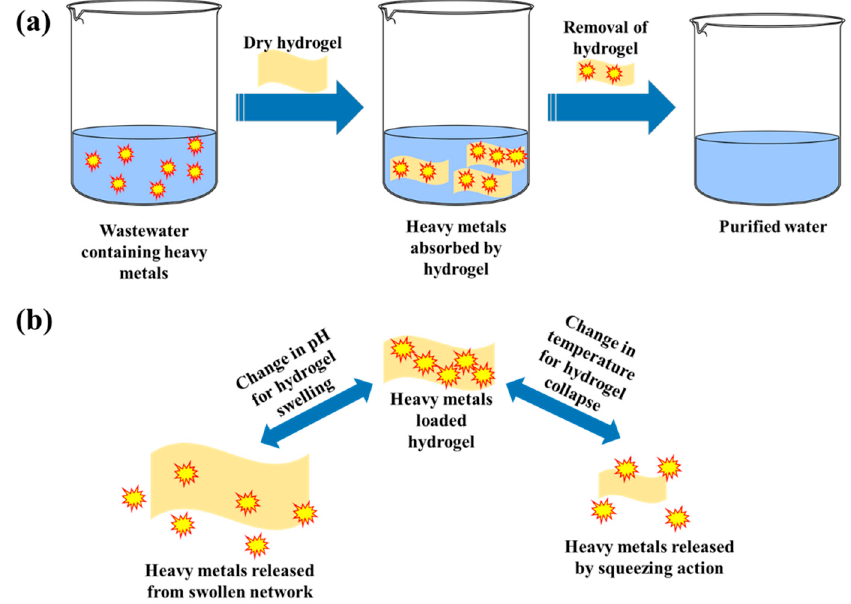
Figure 3. ( a ) Schematic illustration for removal of heavy metals from wastewater by using hydrogel- based adsorbent material. ( b ) Change in structure on applying external stimuli like pH and temperature.